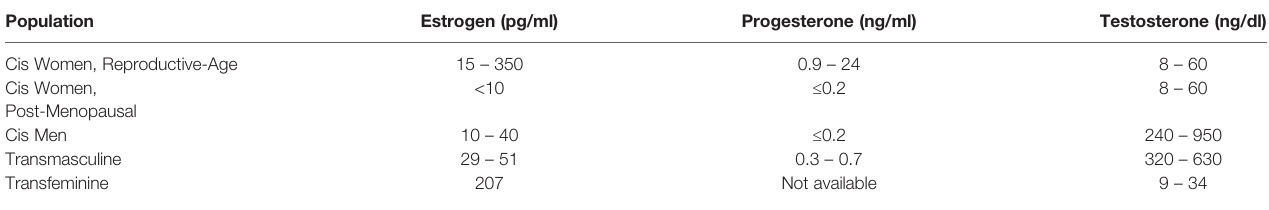
TABLE 2 | Expected Serum Hormone Ranges of Populations of Interest (Leinung et al., 2018; Greene et al., 2019; Greene et al., 2020; M. C. Laboratories, 2021). Population Estrogen (pg/ml) Progesterone (ng/ml) Cis Women,